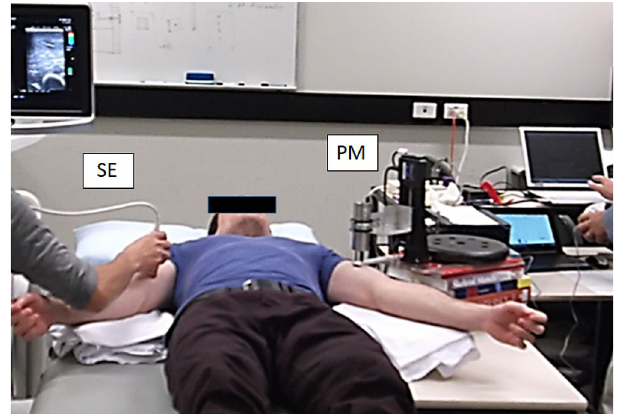
Figure 2. Muscle hardness assessment. Biceps brachii muscle hardness of both arms was assessed by a push-in meter (PM) and strain elastography (SE) simultaneously. In this example, SE for the right arm, and PM for the left arm. (Microsoft Powerpoint 2019, https:// www. micro soft. com/ ja- jp/ micro soft- 365/ power